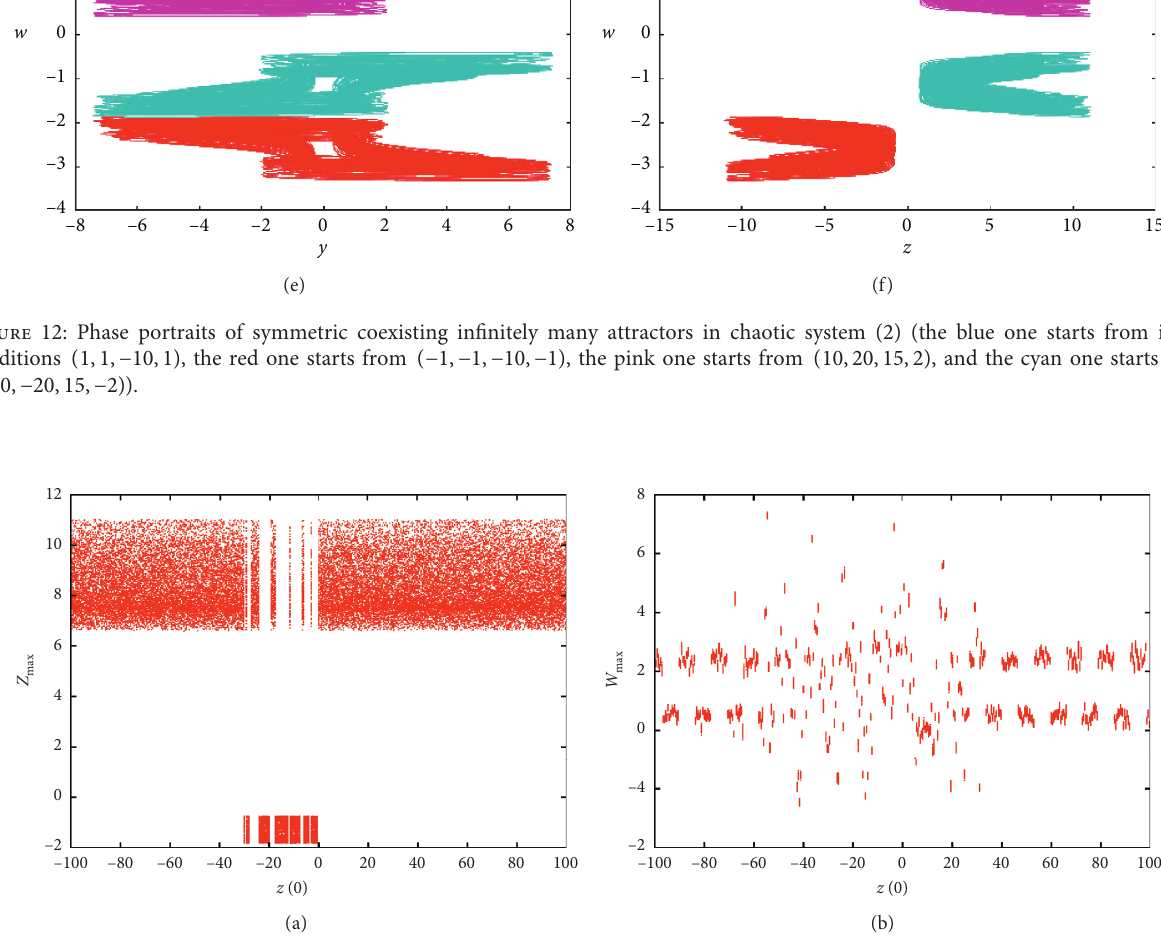
Figure 13: (a) Bifurcation diagram of the state variable z and (b) bifurcation diagram of the state variable w with respect to initial conditions ( 1 , 1 , z ( 0 ) , 1 ) .